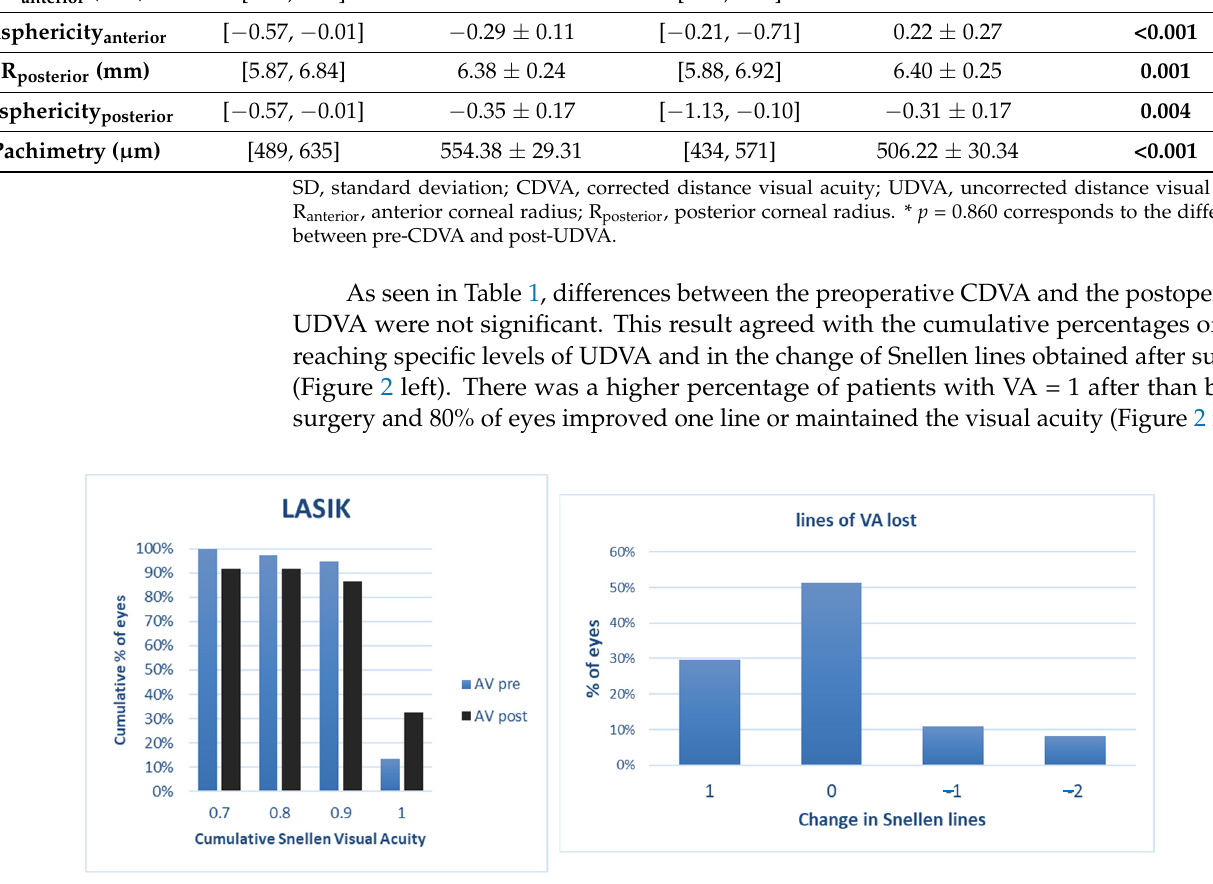
Figure 2. Cumulative percentages of eyes reaching specific levels of visual acuity without correction after LASIK surgery. Preoperative CDVA and postoperative UDVA are compared ( left ). Changes in Snellen lines when postoperative UDVA and preoperative CDVA are compared ( right ).